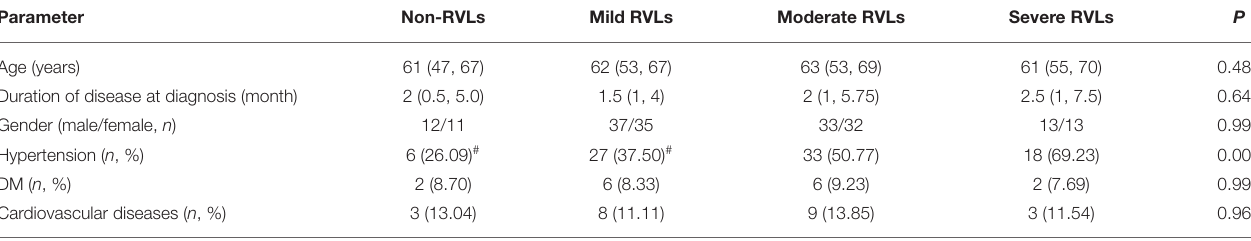
TABLE 1 | The general condition of the non-renal vascular lesion (RVL), mild RVL, moderate RVL, and severe RVL groups.